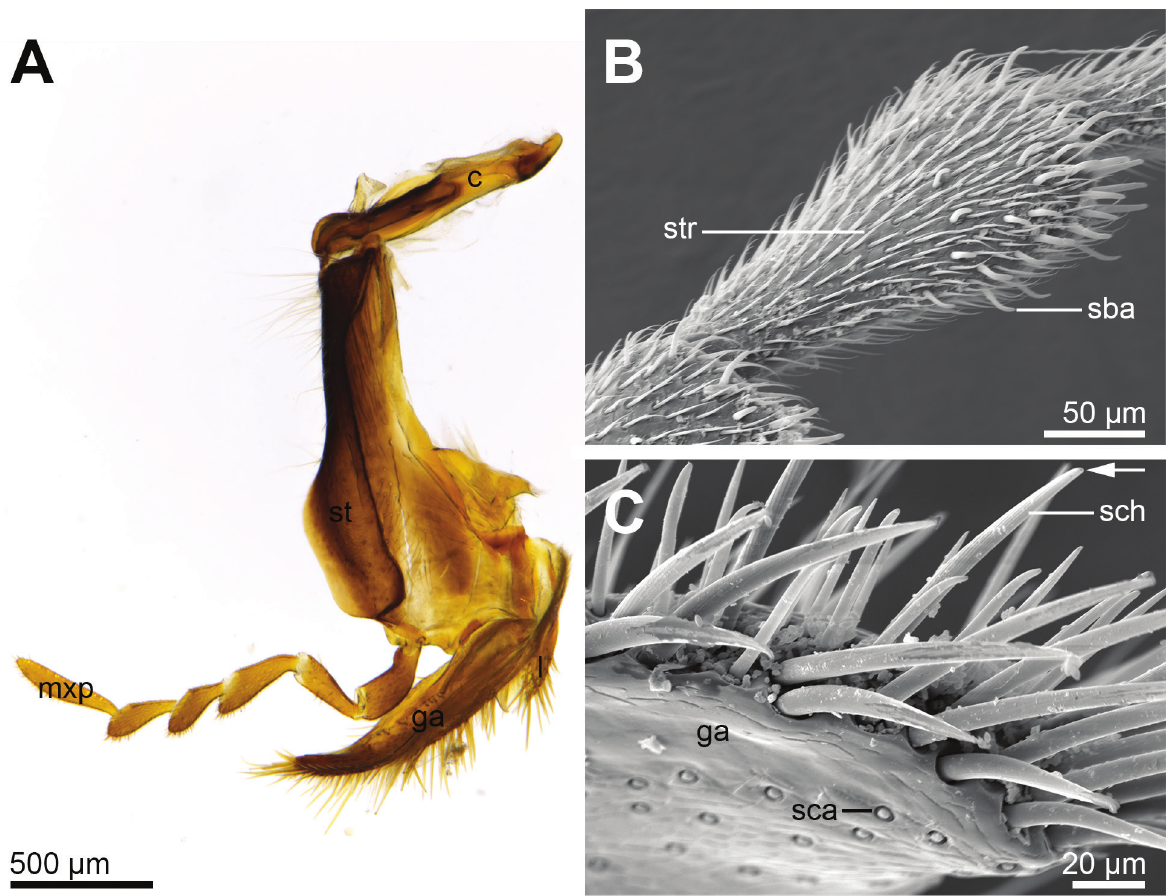
Figure 5. A. Maxilla (LM); c – cardo, ga – galea, l – lacinia, mxp – maxillary palpus, st – stipes. B. Fifth segment of maxillary palpus equipped with various sensilla (SEM); sba – sensillum basiconicum, str – sensillum trichodeum. C. Sensilla at the distal edge of galea ( ga ) (SEM); arrow indicates terminal pore; sca – sensillum campaniformium, sch – sensillum